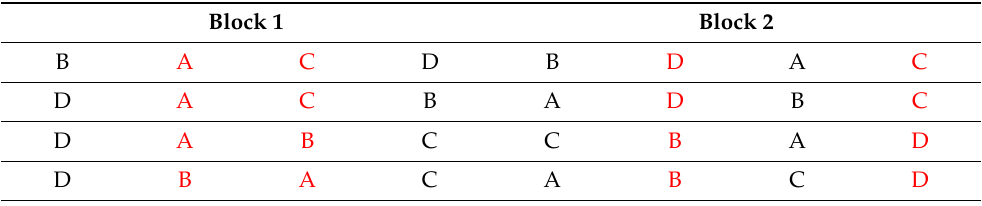
Table 3. Experimental design and layout in